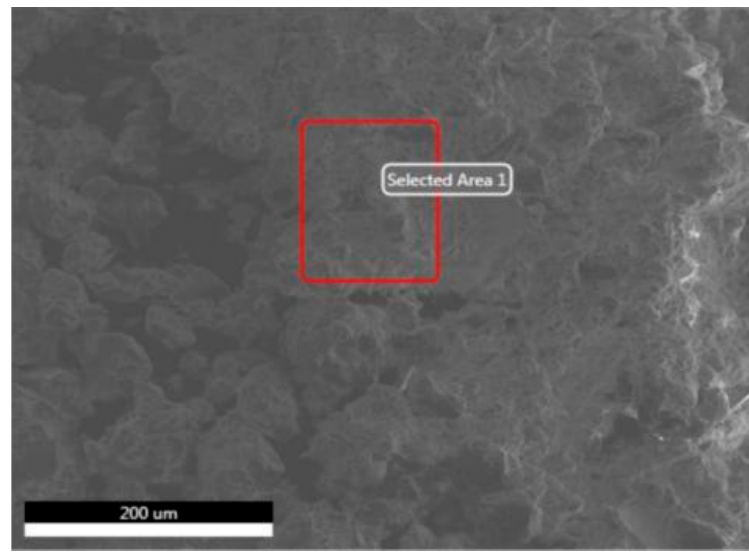
Figure 10. A-0 selection of energy spectrum region of soil sample.